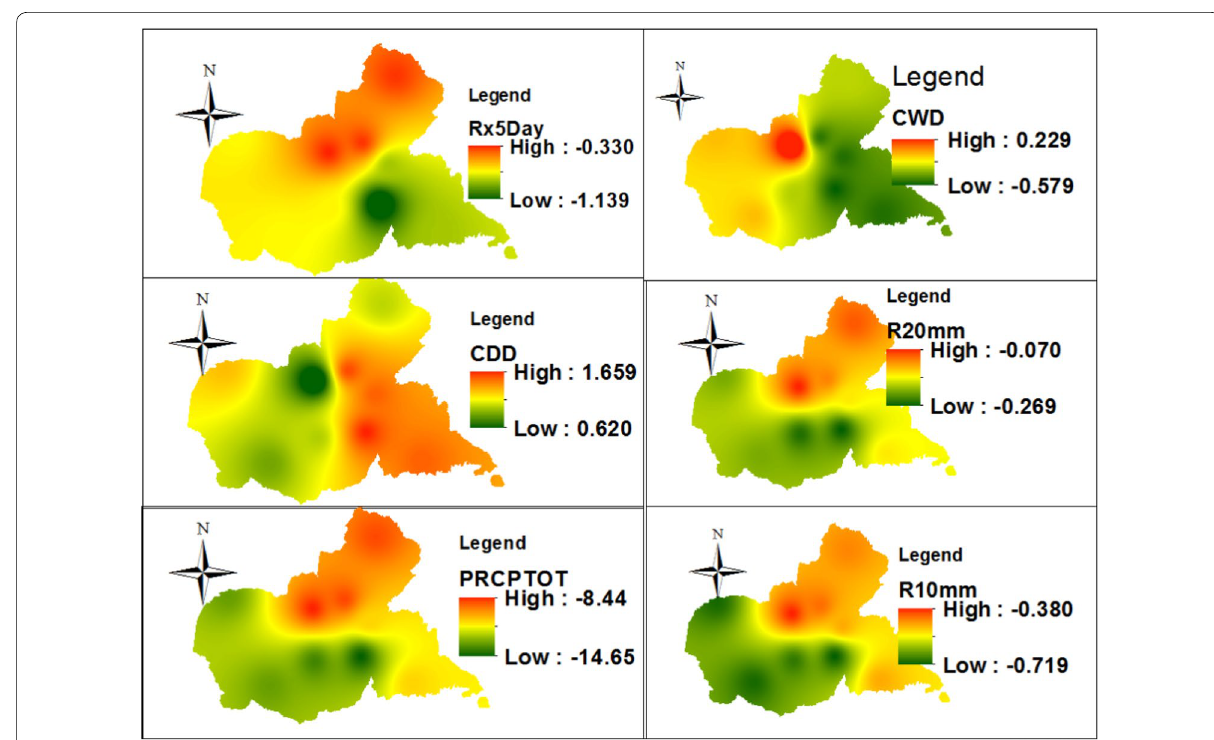
Fig. 17 Total rainfall (PRCPTOT), CDD (consecutive dry days), R10mm (heavy rain days), R20mm (very heavy rain days), Rx1Day (maximum 1